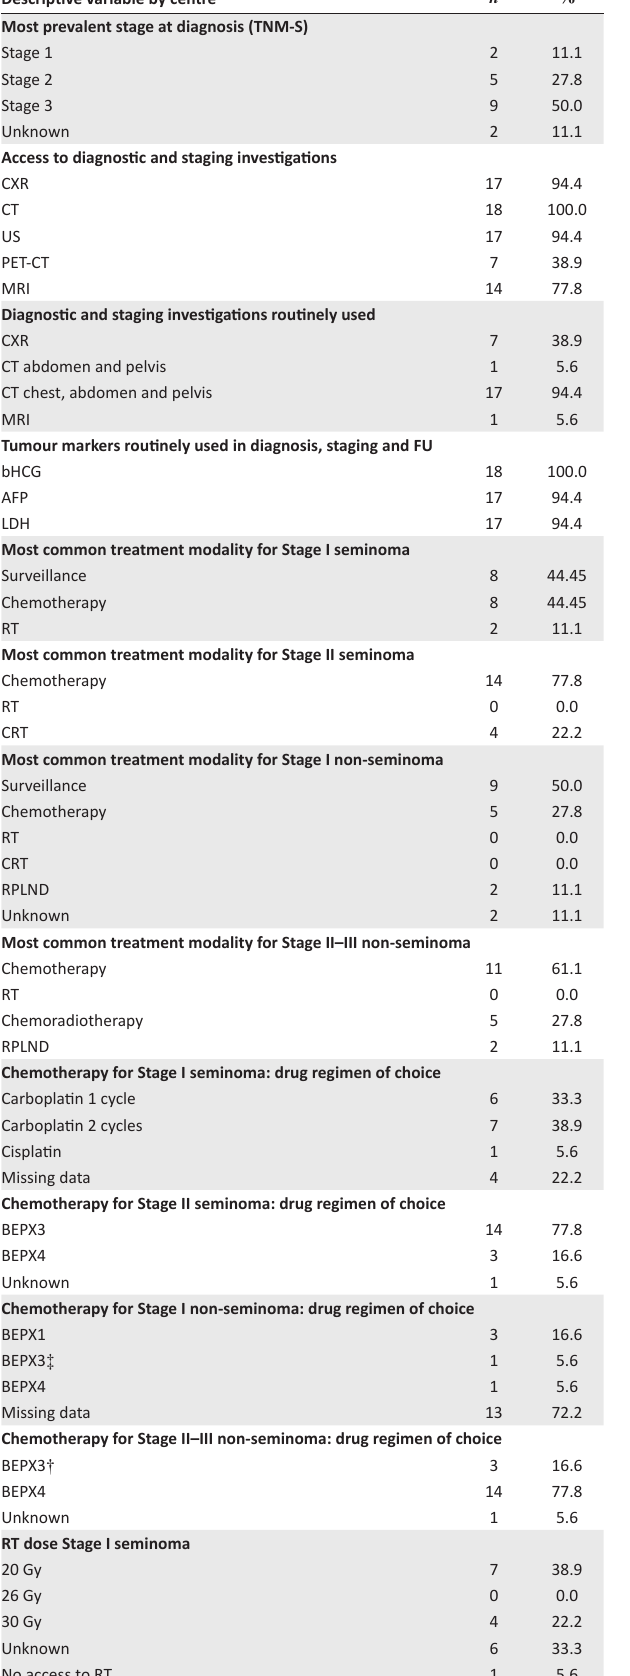
TABLE 4: Patterns of staging, treatment † and follow-up ( n = 18). Descriptive variable by centre